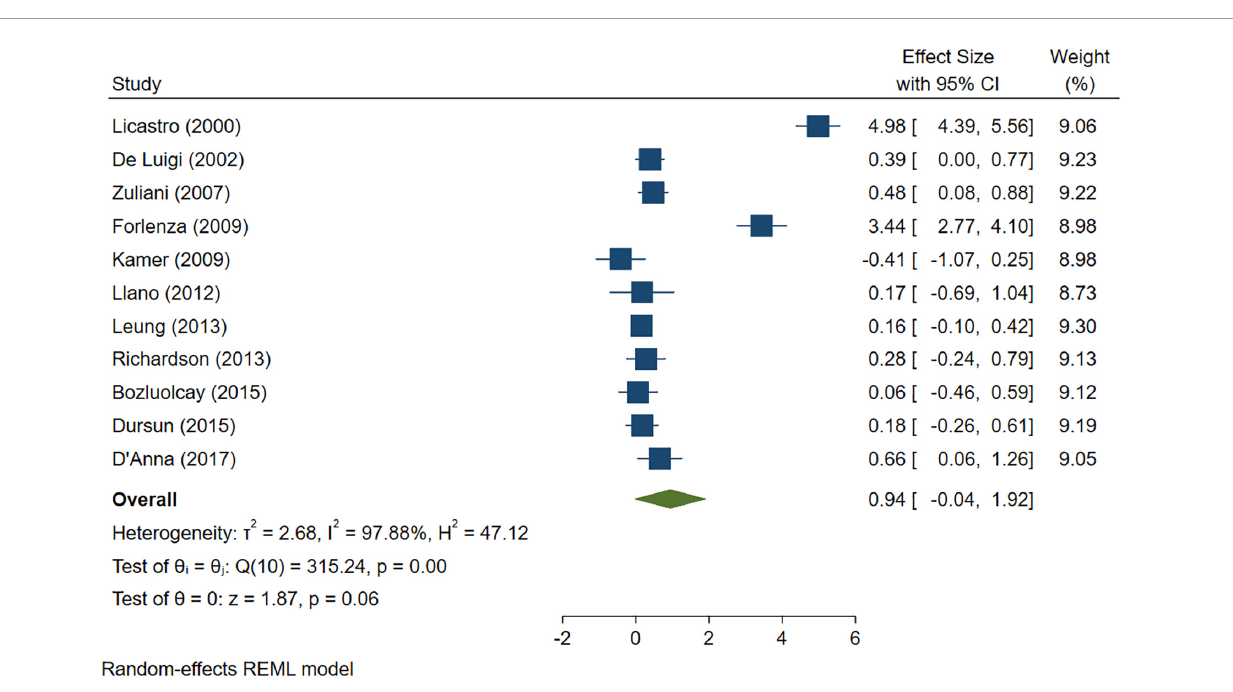
FIGURE3 Forest plot of pooled Hedge’s g depicting high IL-1 β concentration in Alzheimer’s disease (AD) samples compared to